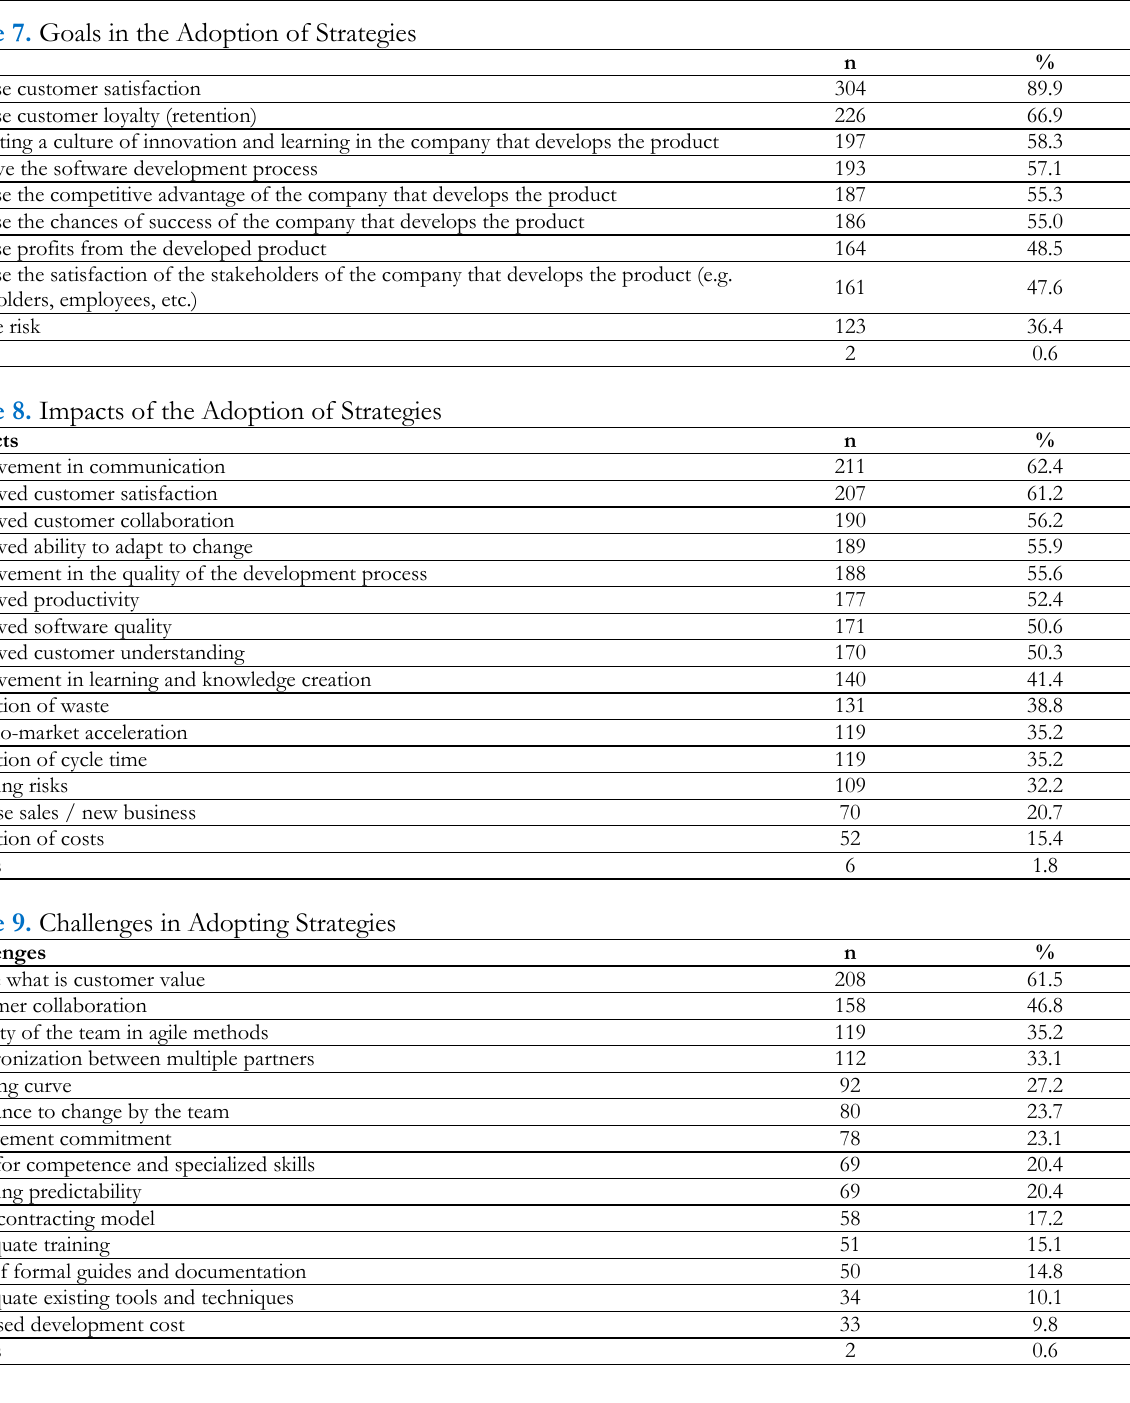
Table 7. Goals in the Adoption of Strategies Goals